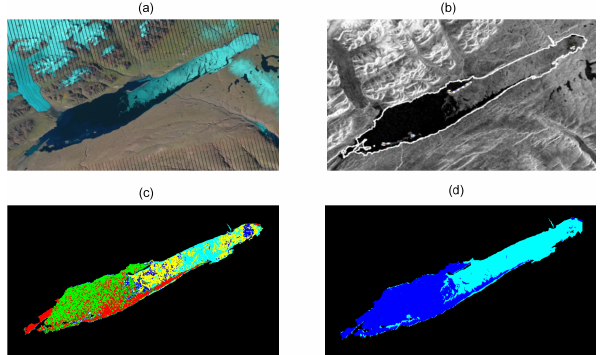
Figure 2. SAR-image segmentation processing steps: (a) Landsat image of Lake Hazen, 19 July 2010; (b) original ASAR image of Lake Hazen acquired on 19 July 2010; (c) K -means classified image (five clusters); (d) two-class map of ice (light blue) and open water (dark blue). The white line in the original SAR image represents the lake polygon that was used for defining the ROIs covering the